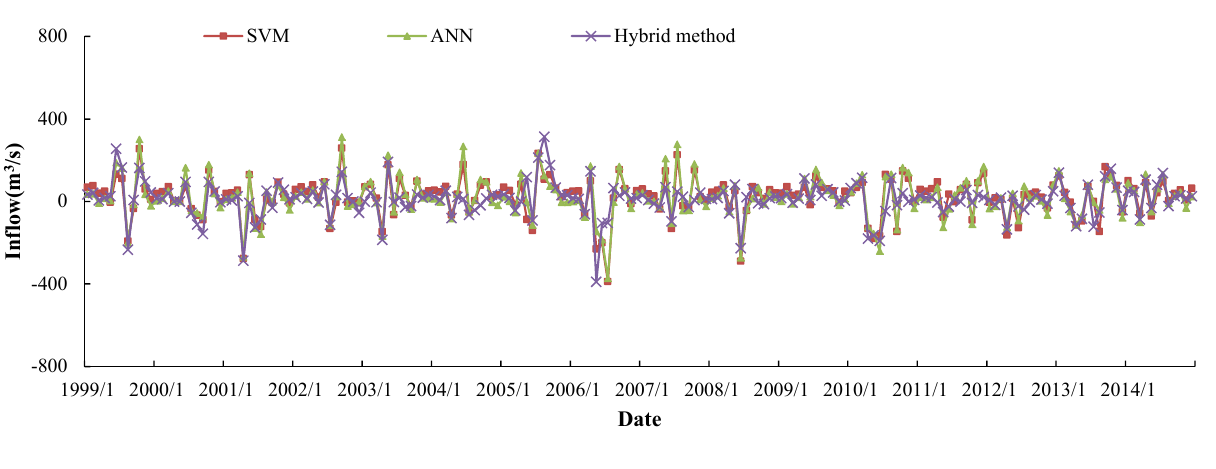
Figure 10. Comparison of errors by various methods during the validation period. y = 1.124 x - 47.866 R² = 0.792